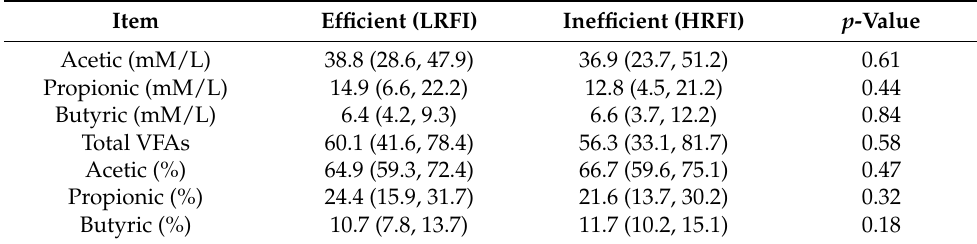
Table 6. Volatile fatty acids (VFAs) for LRFI and HRFI 1